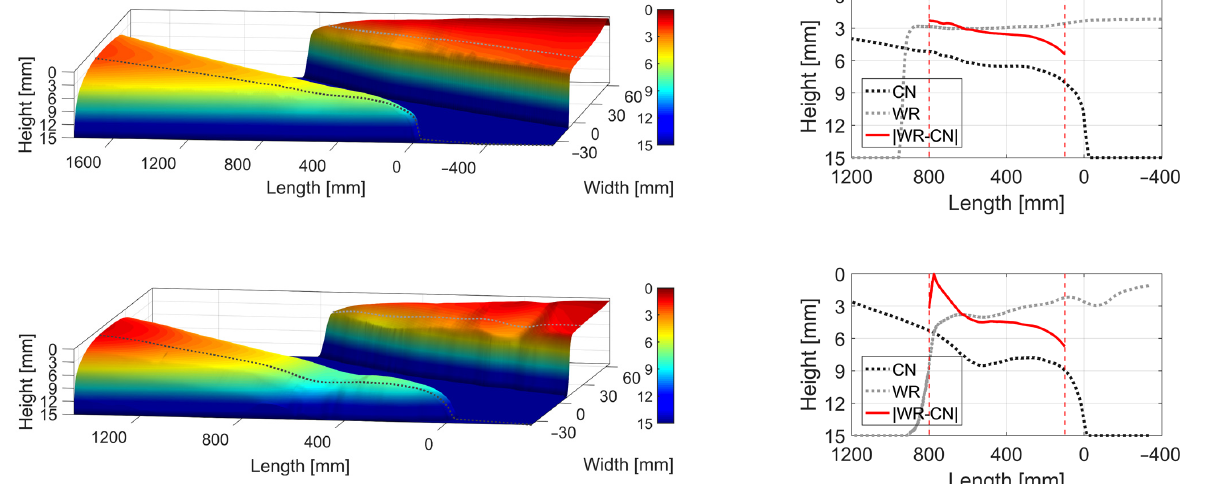
Figure 5. Crossing panel HO 22A ( top ) and VAD 131 ( bottom ): crossing transition 3D scan ( left ) and longitudinal height profiles in transition region for the crossing nose and the wing rail ( right ). The crossing nose (CN) is to the left and the wing rail (WR) is to the right. The longitudinal cross-sections (between vertical, dashed lines) at representative lateral positions illustrate profile degradation.